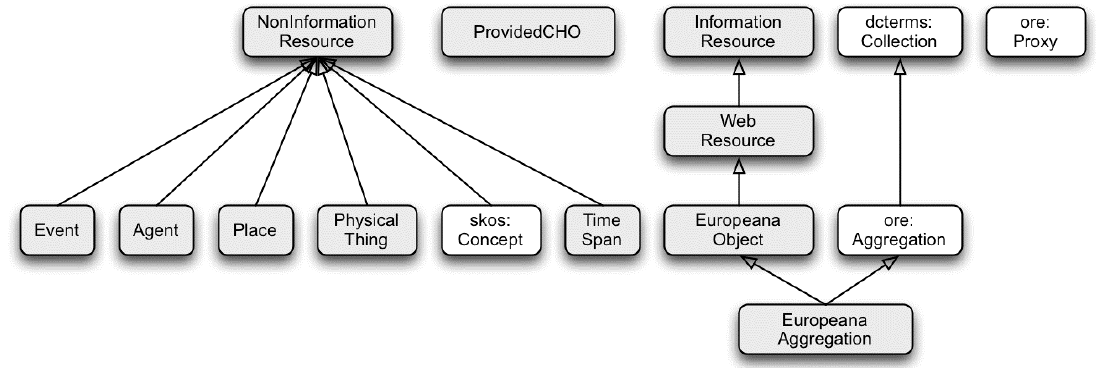
Figure 1. General overview of the classes defined in the Europeana Data Model. The ‘ProvidedCHO’, representing a cultural heritage object, is the central point of an EDM metadata record [5].